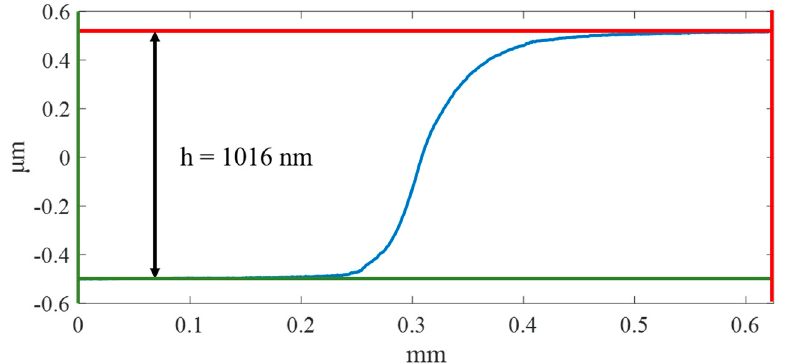
Figure 12. Height − error due to tilt (red horizontal line: the coated area, green horizontal line: the uncoated area, blue line: step height